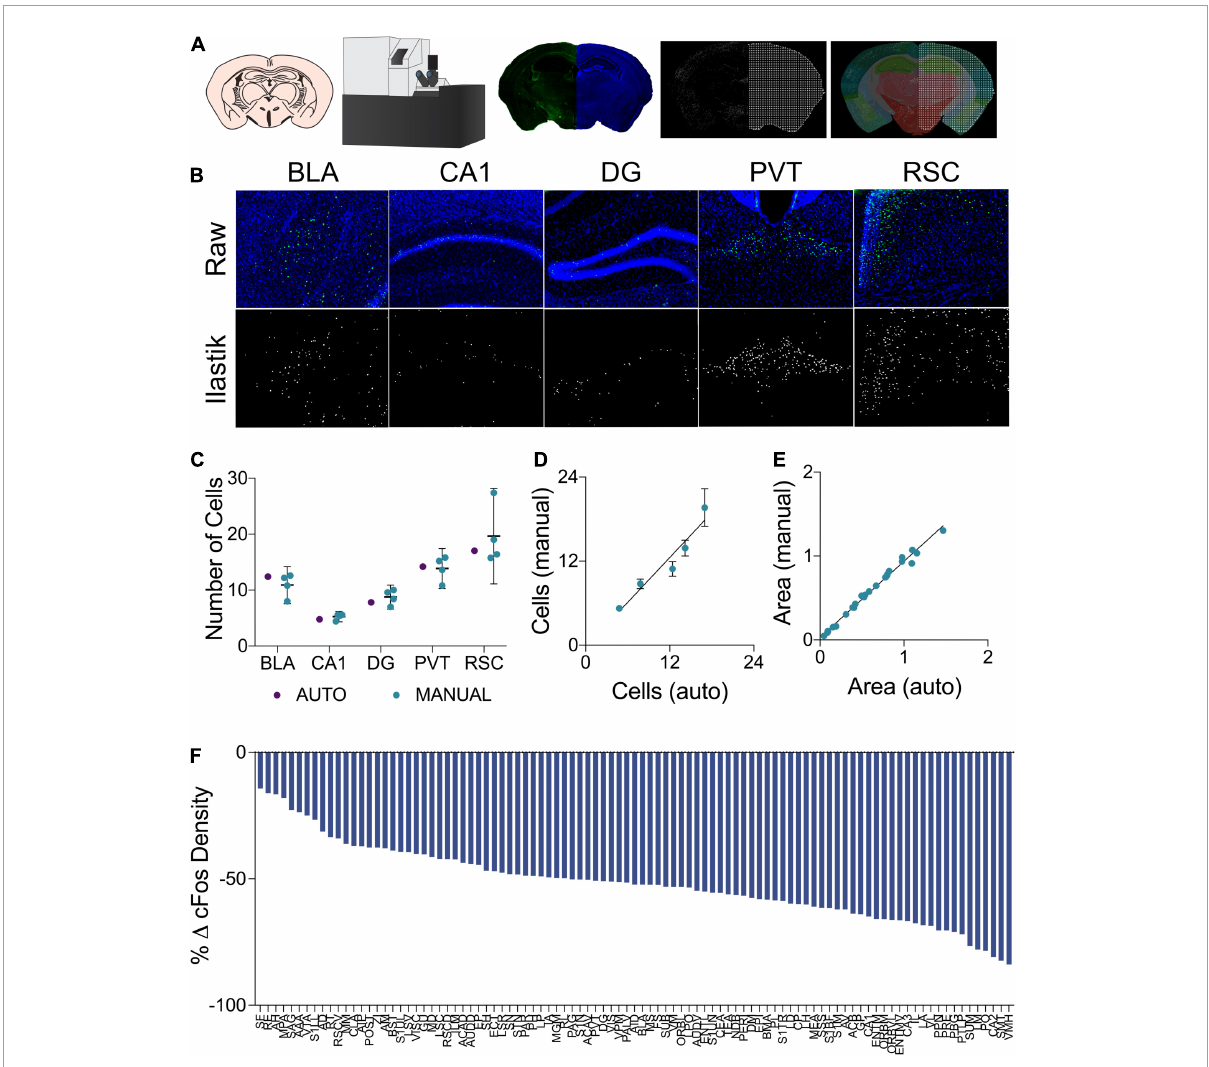
FIGURE2 (A) In the cell segmentation and tissue registration pipeline, tissue was sectioned, immuno-labeled, and mounted on slides prior to being imaged on a fluorescent slide scanning microscope. Images of labeled c-Fos and DAPI staining were then processed using Ilastik and ImageJ to generate binary c-Fos labels and a mask of evenly spaced grid points in the shape of the tissue sections. These binary images were then applied to plates from the Allen Mouse Brain Atlas which had been morphed to align with the tissue sections using Whole Brain , yielding regional c-Fos densities. (B) Examples of raw c-Fos + cells in the BLA, CA1, DG, PVT, and RSC (top, L-R) and cells segmented using Ilastik (bottom). (C) A set of ROIs was quantified for validation. Automated Ilastik segmentation yielded cell counts within the 95% confidence intervals of counts acquired from trained independent experimenters in each of the aforementioned regions (Two-Way ANOVA; segmentation method factor: F 1 , 15 = 0.09515, p = 0.7620). Data presented as mean 95% ± confidence interval. (D) Cell counts collected using automated Ilastik processing were found to correlate highly with mean counts gathered through manual counting ( Pearson r = 0.9610, p < 0.01). Data presented as mean 95% ± confidence interval. (E) Area approximations generated using the pipeline were correlated with areas acquired by tracing regions manually in ImageJ ( Pearson r = 0.9941, p = < 0.0001). (F) c-Fos quantification across the 97 brain regions of interest. Relative to the control group, c-Fos expression in the mice that had previously received Morris Water Maze training was decreased to a variable extent in all brain